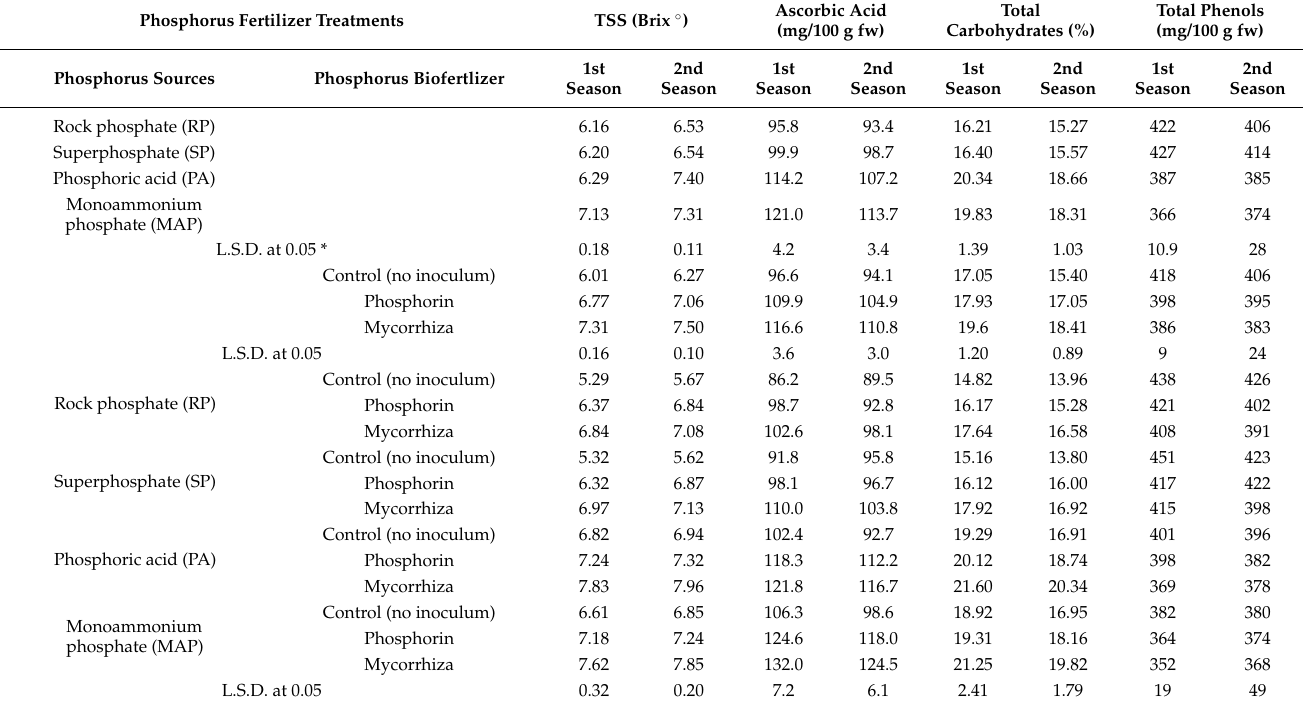
Table 8. The effect of phosphorus sources and bio-fertilizers application on quality parameters of broccoli heads during the 2018 (1st) and 2019 (2nd)